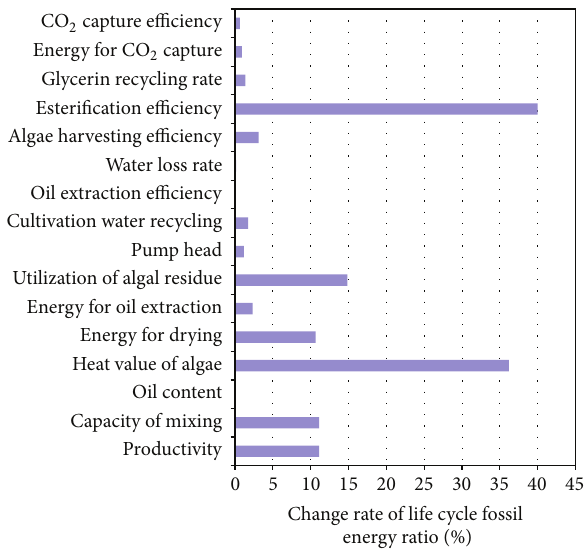
Figure 8: Sensitivity analysis of effects of several parameters on life cycle fossil energy ratio of algae biodiesel.